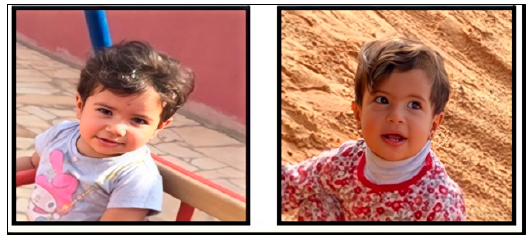
Figure 22. Samples of False prediction